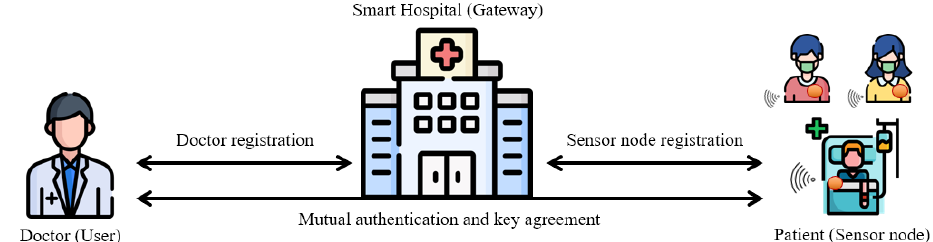
Figure 1. The general system model of